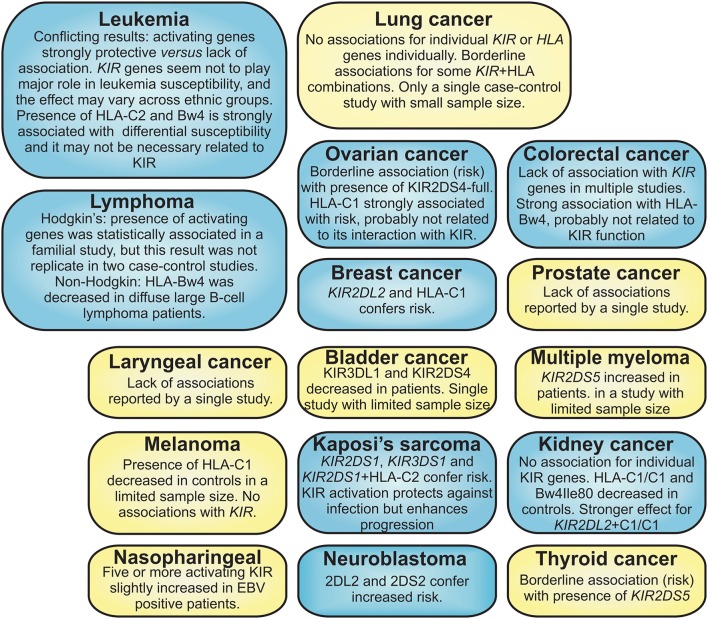
Summary of the cancers for which KIR polymorphism have been analyzed. Blue boxes = statistically significant association of cancer with KIR and/or HLA ligand; yellow boxes = borderline associations, lack of association or studies with reduced sample size.